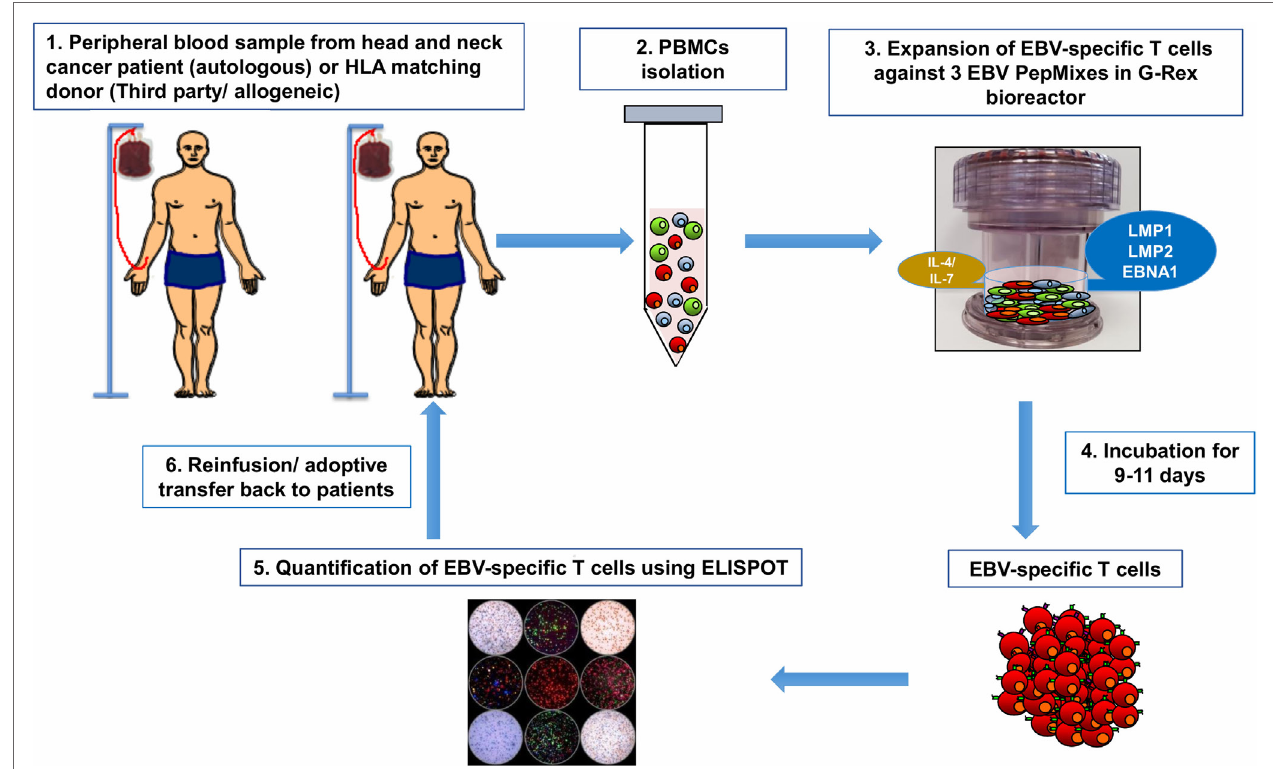
FiGURe 3 | From bedside to bench and back again: Epstein–Barr virus (EBV)-specific T cells can be isolated from peripheral blood of patient with head and neck cancer then reactivated and stimulated in vitro to increase their number and promote their specificity (1). If the patient’s antiviral memory T cells are inexistent or their activity is dampened by the immunosuppressive tumor microenvironment (regulatory T cells, myeloid-derived suppressor cells, and/or inhibitory cytokines/ chemokines), virus-specific T cells (VSTs) can be obtained from peripheral blood of human leukocyte antigen (HLA)-matching sibling or from third party partially HLA-matched seropositive donor (1). Peripheral blood mononuclear cells (PBMCs) will be isolated from patient/donor peripheral blood by Ficoll-Hypaque density gradient centrifugation (2). To generate EBV-specific T cell lines, PBMCs will be pulsed in vitro with a mixture of three overlapping PepMix peptides representing the EBV viral antigens (latent membrane protein 1, latent membrane protein 2, and EBV-induced nuclear antigen 1) present on nasopharyngeal cancer (NPC) tumor cells. PBMCs are suspended in specific culture media supplemented with IL4 and IL7 and then transferred to a G-Rex ® culture device (3). After 9–11 days of culture, VSTs are harvested and assessed for viability and quantity (4). The viral specificity of these T cells will be assessed by ELISPOT assay (5). The expanded EBV-specific T cells obtained from the patient or the HLA-matching donor will be infused back onto patient peripheral blood (6) as autologous and allogeneic adoptive T cell therapy,